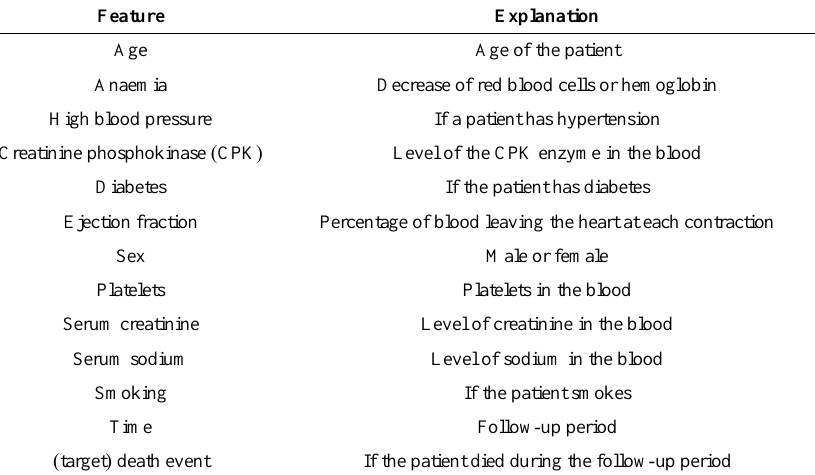
Table 1. The details of heart failure dataset